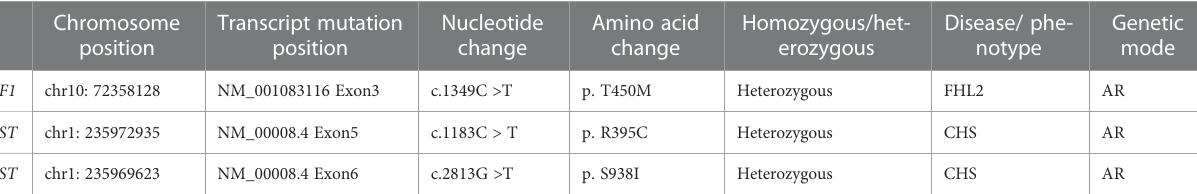
TABLE 2 Genetic test* results of Case 2.